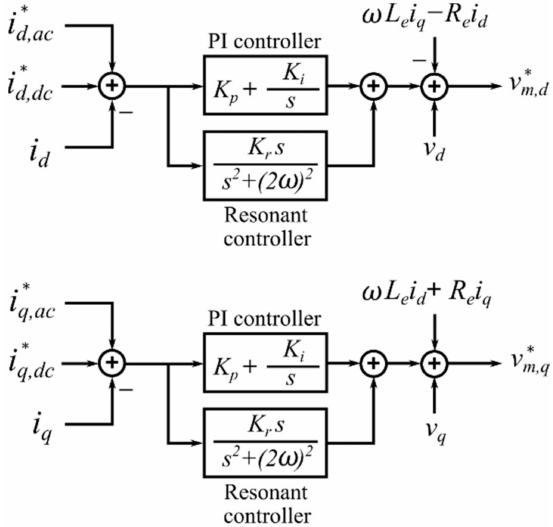
Figure 4. Inner current control system.